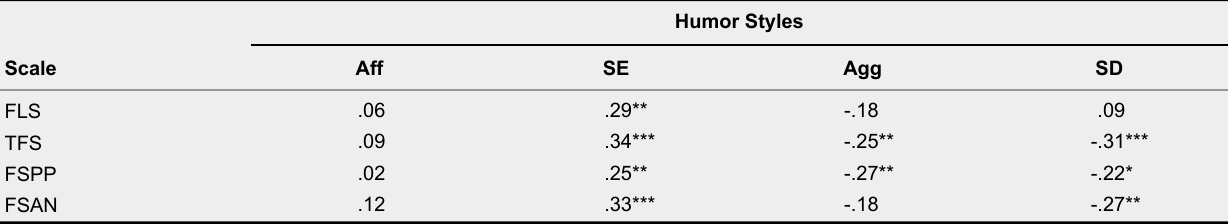
Pearson-Product Moment Correlations Between the Four Humor Styles and the Four Forgiveness